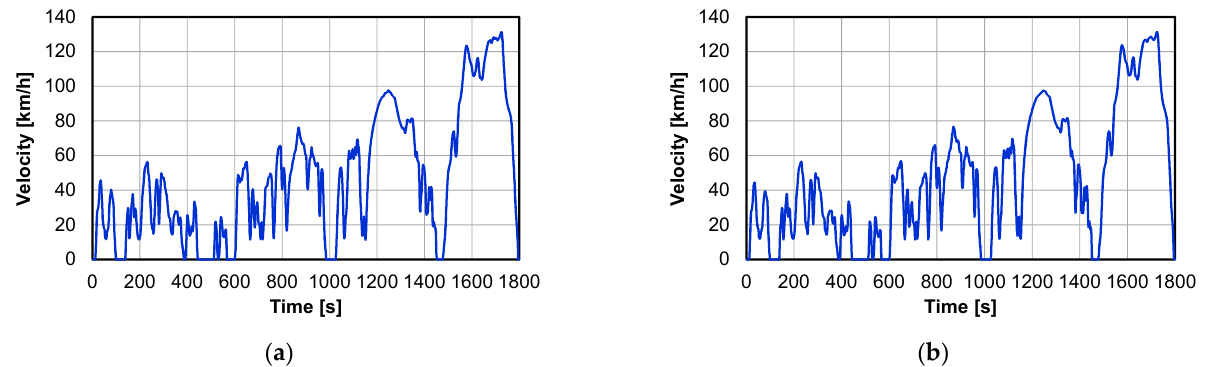
Figure 3. The scheduled velocity of the vehicles during WLTC driving cycle for: ( a ) plug-in; ( b ) HEV.